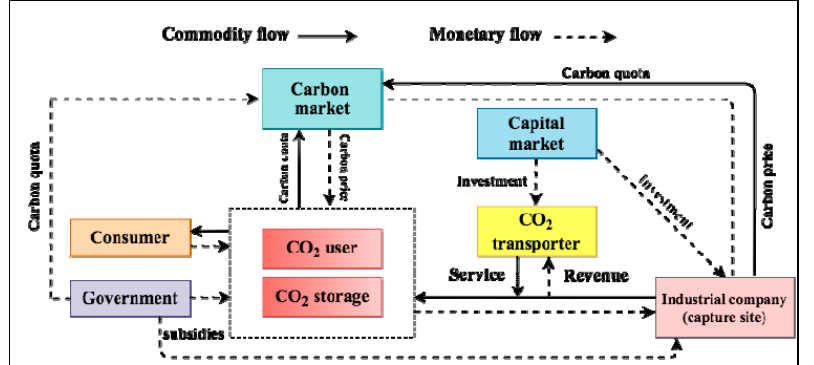
Figure 7. CCUS transporter business model. Adapted from [20].